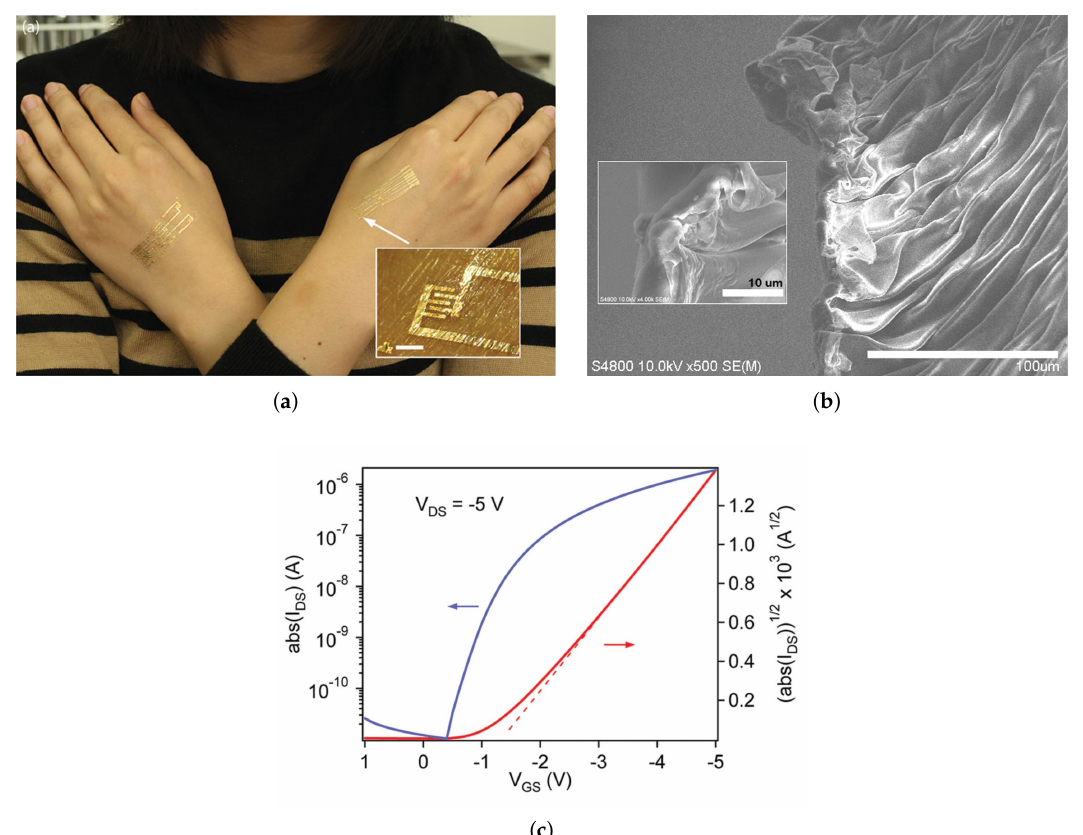
Figure 12. Ultrathin, flexible, and biocompatible organic electronic TFT, ( a ) shown laminated on human skin. The inset shows a zoomed view of a tactile sensor, with skin grooves visible. The scale bar is 2 mm. ( b ) SEM image indicating ultra-small film wrinkles. The scale bars are 100 µ m in the main image, and 10 µ m in the inset. ( c ) Transfer curve of organic TFT. [141]. Reproduced with